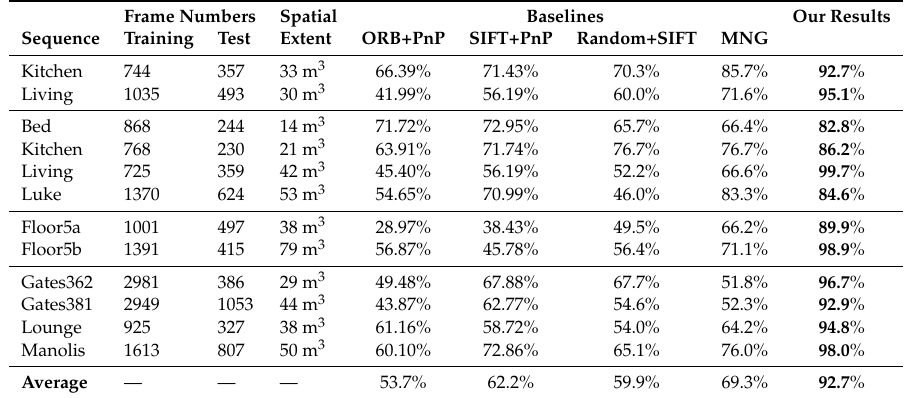
Table 1. Camera re-localization results for the indoor dataset compared with state-of-the-art